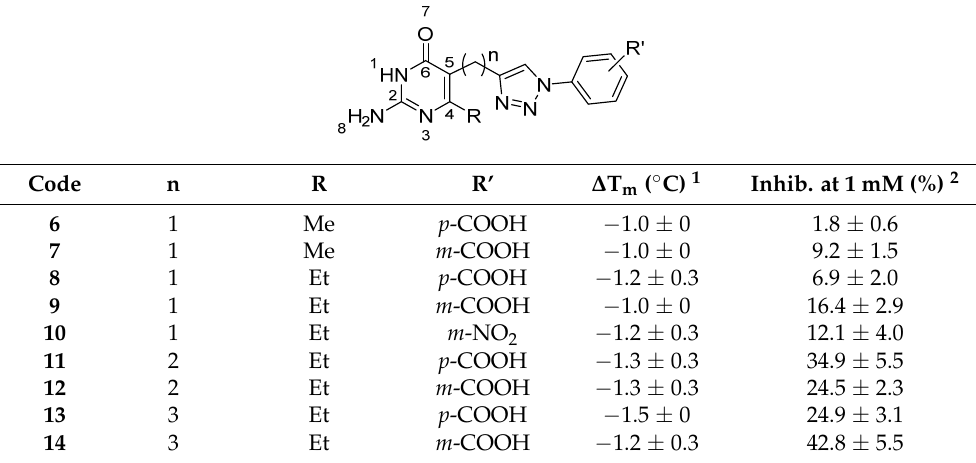
Table 2. Structure and screening data for phenyltriazolyl-2-amino-4-pyrimidinone hit compounds (series 2).